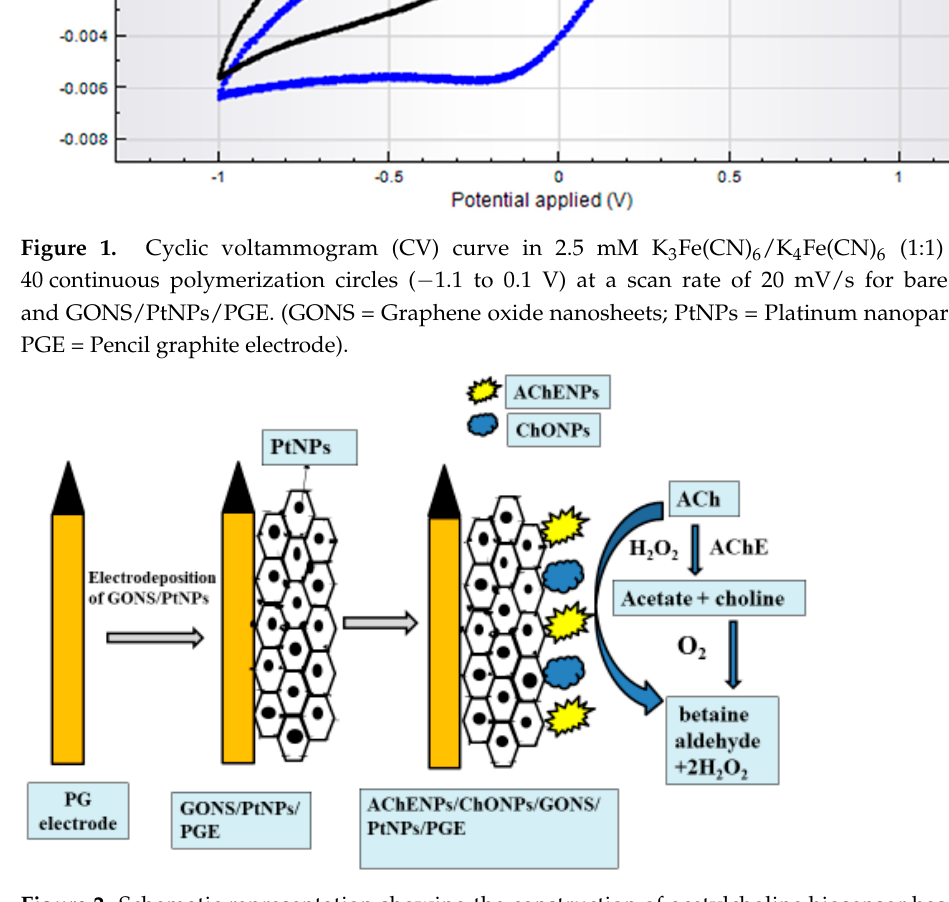
Figure 2. Schematic representation showing the construction of acetylcholine biosensor based on AChENPs/ChONPs/GONS/PtNPs/PGE. (AChENPs = Acetylcholine esterase nanoparticles; ChONPs = Choline oxide nanoparticles; GONS = Graphene oxide nanosheets; PtNPs = Platinum nanoparticles; PGE = Pencil graphite electrode).